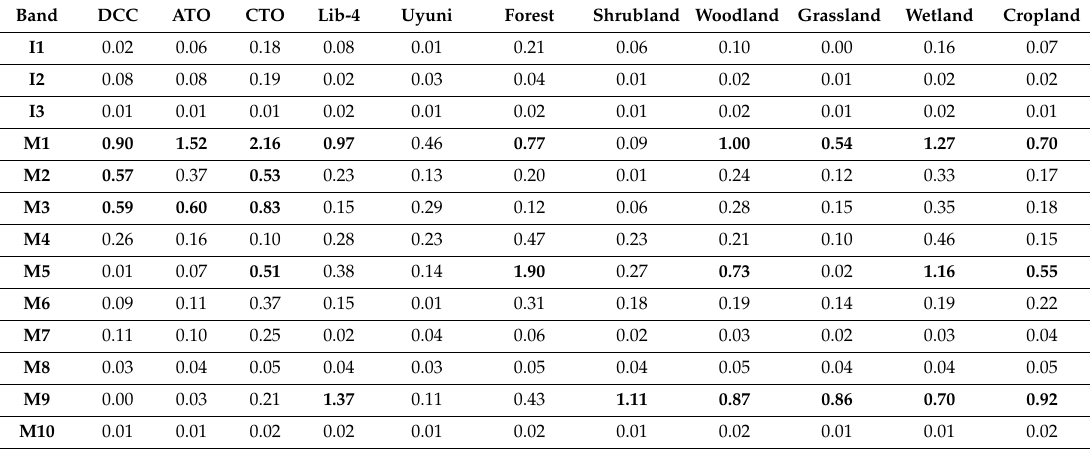
Table 5. S-NPP VIIRS NG RSR Earth-reflected scene-dependent γ for specified 1% extended bandpass limits, shown in